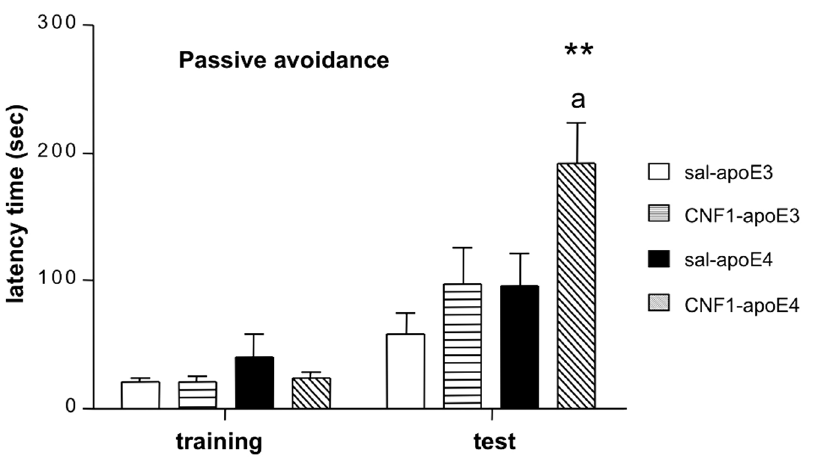
Figure 2. Effects of apoE genotype and CNF1 treatment in the passive avoidance test. Data are shown as latency time to enter the dark compartment on the training day (day 1) and the probe day (day 2) of the test. No differences between experimental groups were observed during training days. CNF1-treated apoE4 mice showed an increase in the latency time to re-enter the dark compartment after the electric shock (p=0.004) compared to all other groups. Results are expressed as mean 6 SEM, n=13–14 animals per group (**p , 0.002 compared to saline-apoE3, a p , 0.048 compared to saline-apoE4 mice).